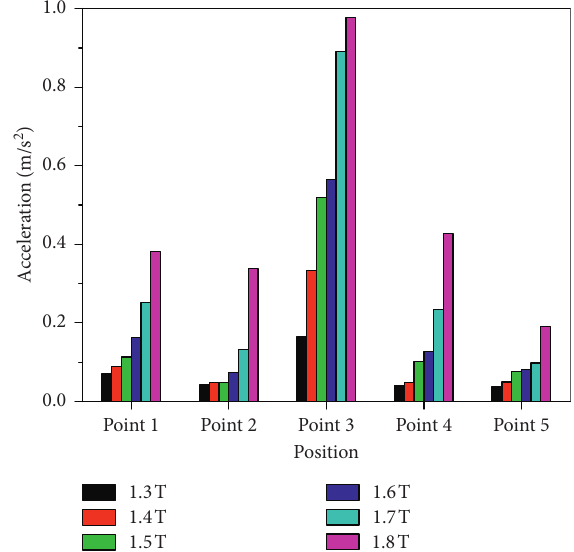
Figure 14: Relationship between the amplitude of fundamental frequency vibration acceleration and square of magnetic density.